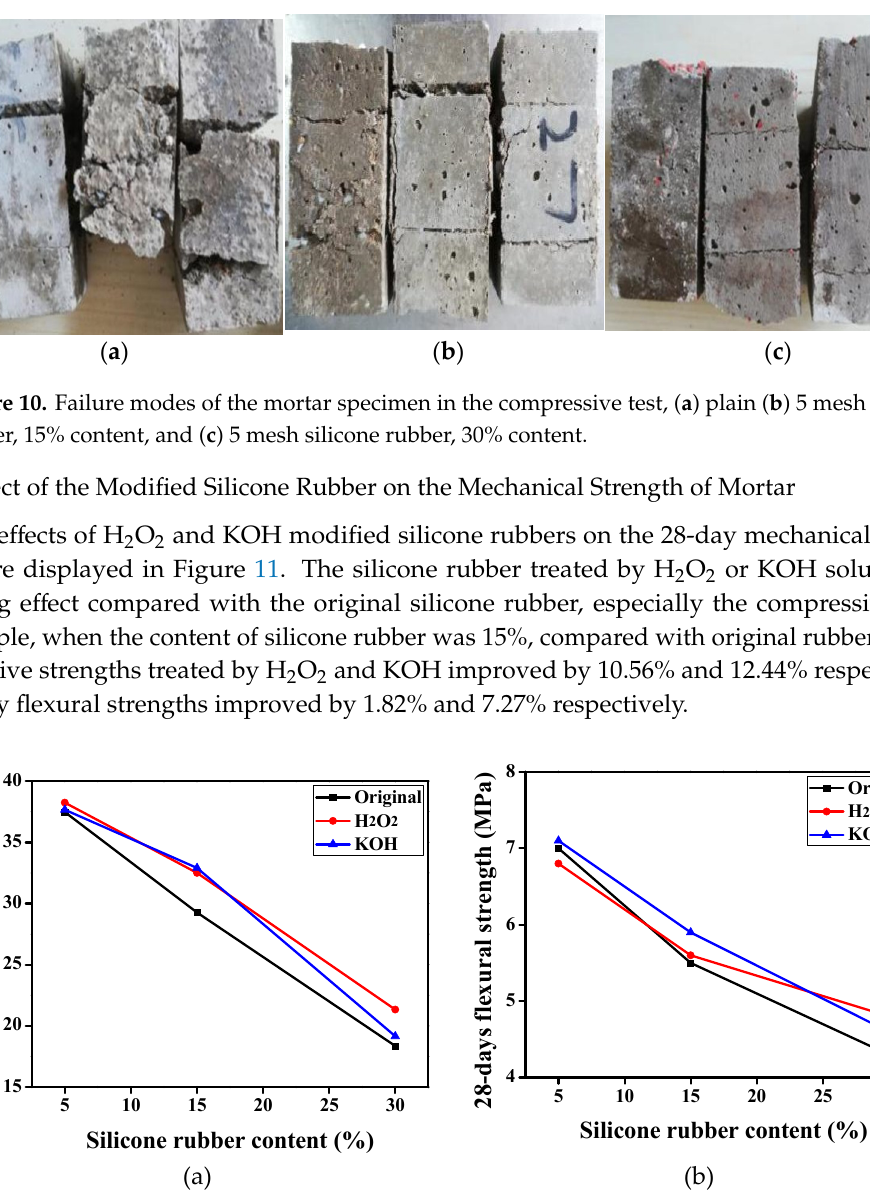
Figure 9. The flexural strength of silicone rubber mortar. ( a ) 7-days; ( b ) 28-days.